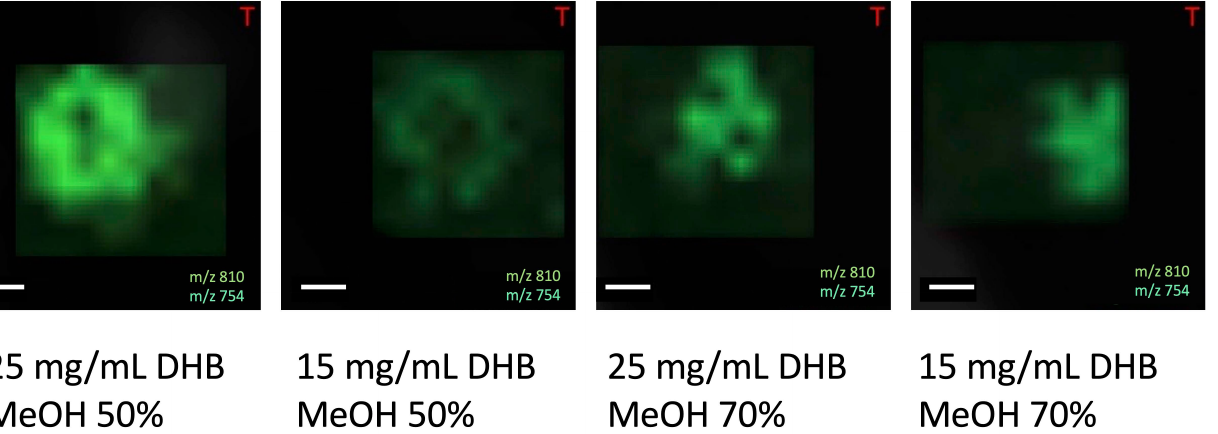
Figure 11. The picture of the oocytes obtained after covering them with matrix of different concentra- tions and solvent compositions, size bar: 100 µ m.